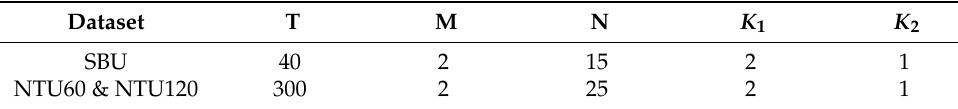
Table 1. The hyperparameter settings in this